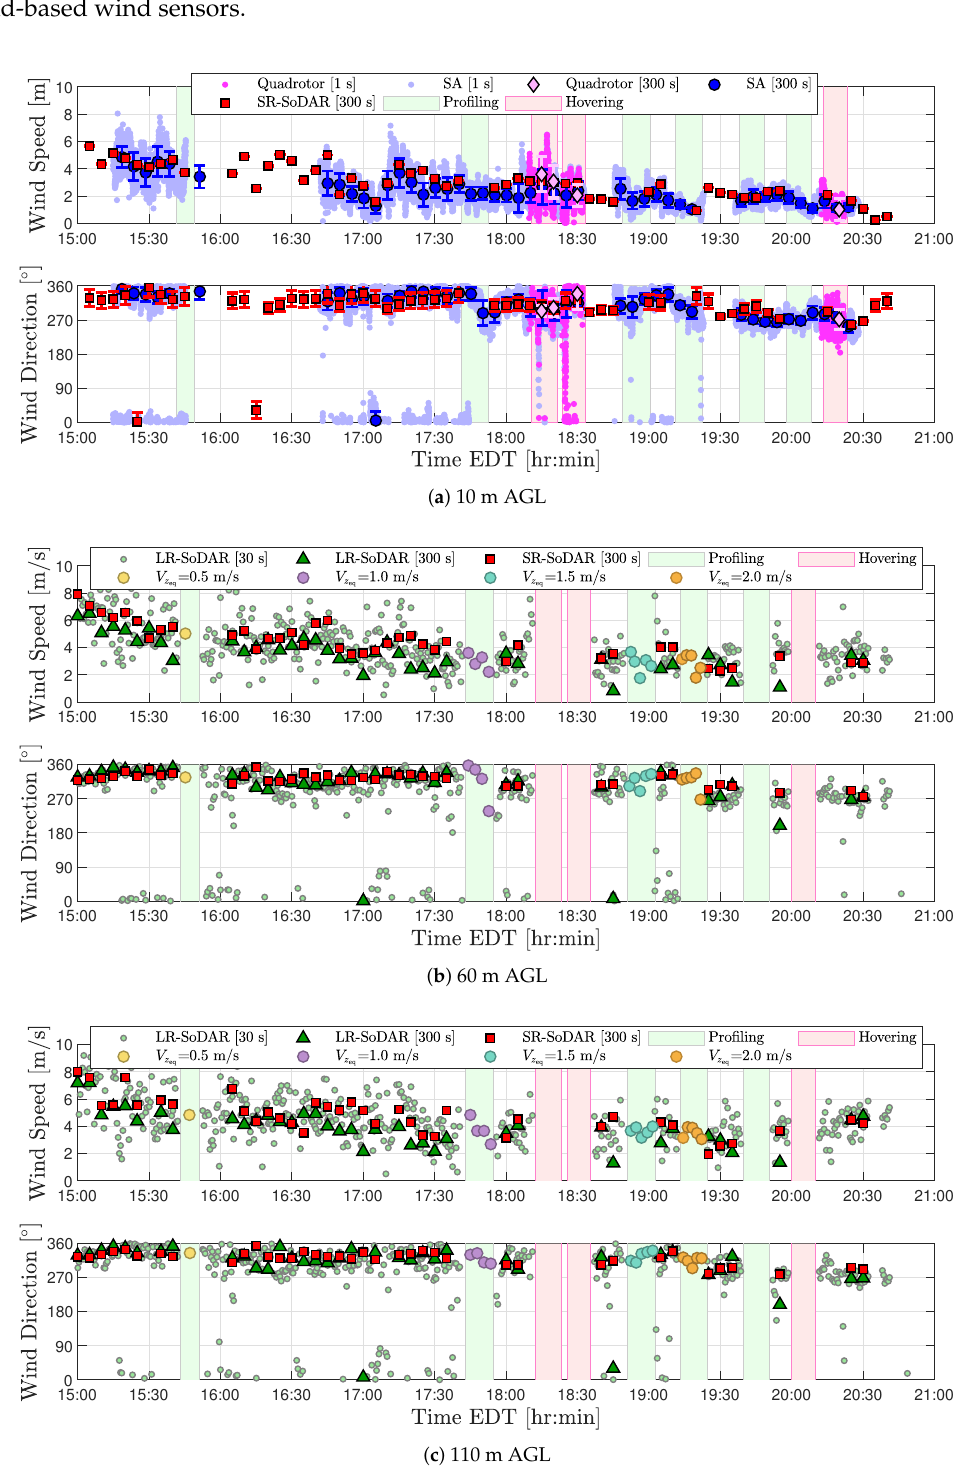
Figure 7. Comparison of wind observations collected from the quadrotor and independent sensors